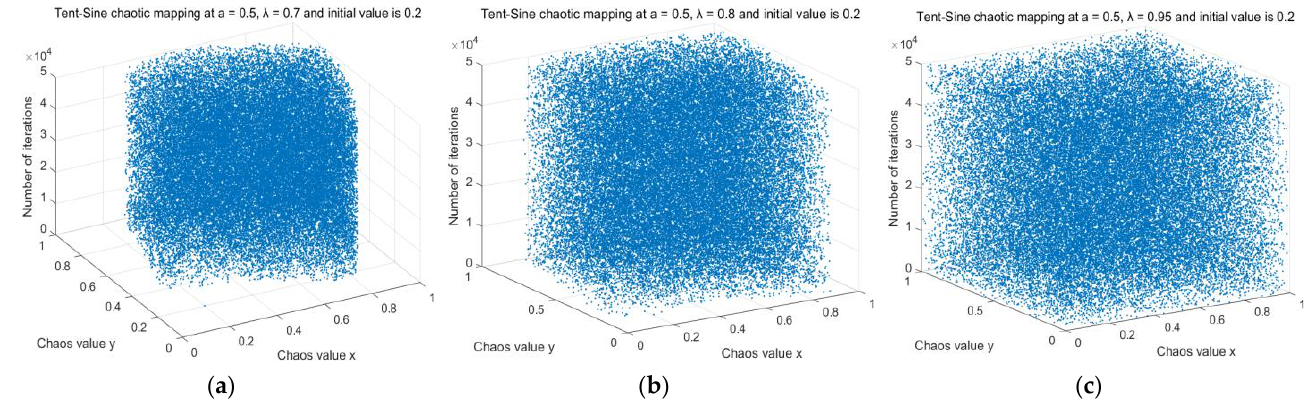
Figure 5. Distribution of generated sequences for Tent–Sine chaotic mapping with different parameters. ( a ) Tent–Sine chaotic mapping at a = 0.5, λ = 0.7, and initial value of 0.2. ( b ) Tent–Sine chaotic mapping at a = 0.5, λ = 0.8, and initial value of 0.2. ( c ) Tent–Sine chaotic mapping at a = 0.5, λ = 0.95, and initial value of 0.2.